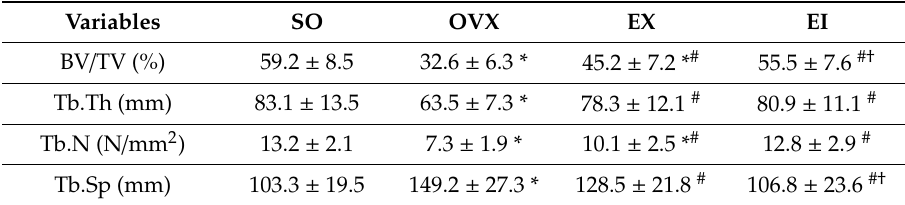
Table 2. Changes in morphological structure of bone.